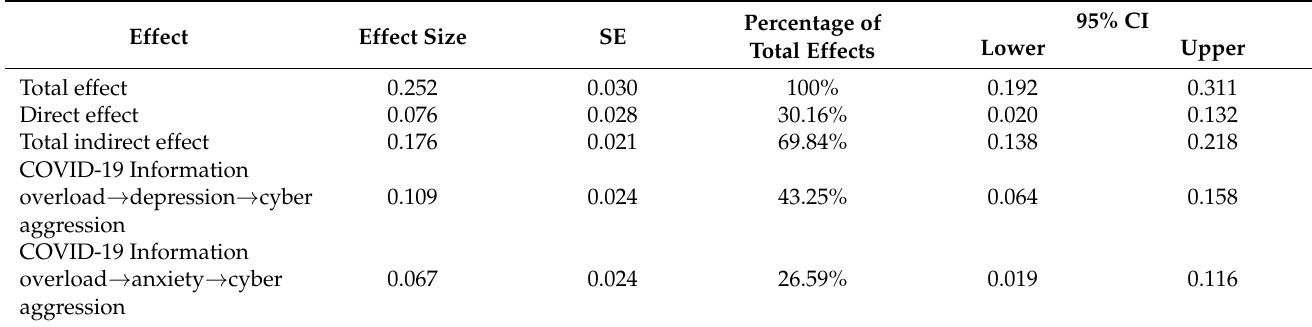
Table 3. Bootstrap analysis of mediation